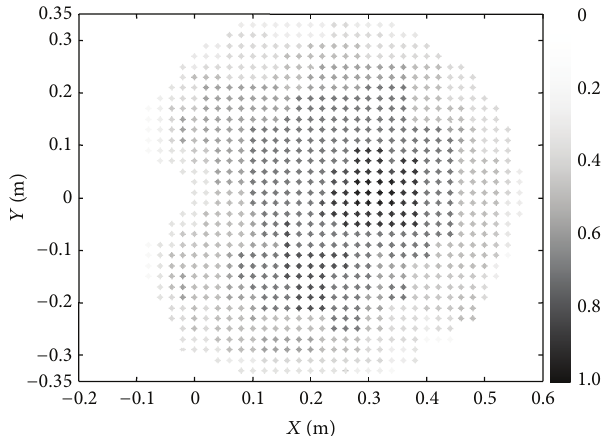
Figure 16: 3D manipulator structure.